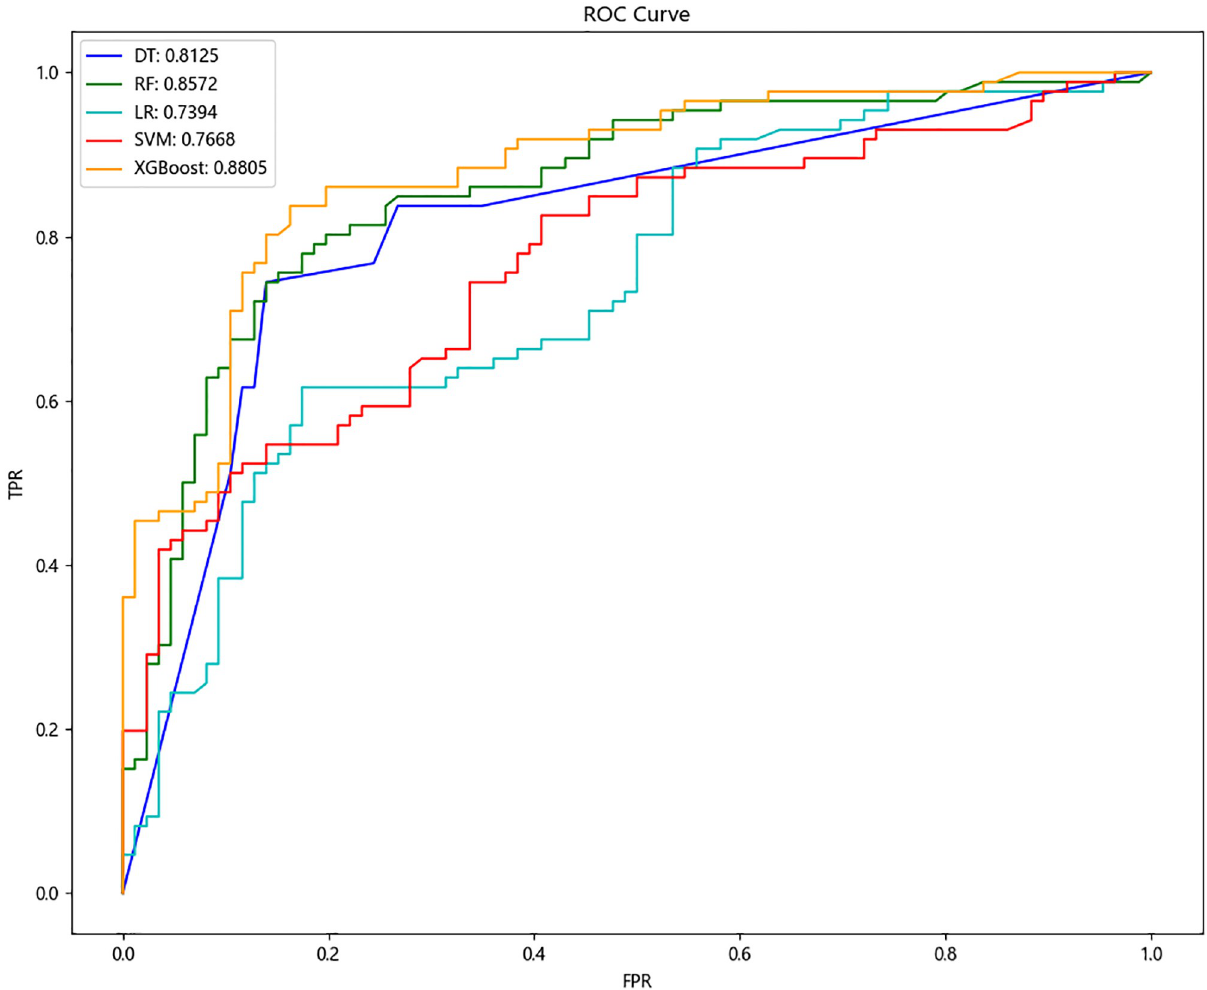
Fig 4. ROC curves for predicting minor amputation in DFU patients with machine learning algorithms after over-sampling. Abbreviations : ROC, receiver operating characteristic curve; DFU, diabetic foot ulcers; DT, decision tree; RF, random forest; LR, logistic regression; SVM, support vector machine; XGBoost, extreme gradient boosting; FPR, false positive rate; TPR, true positive